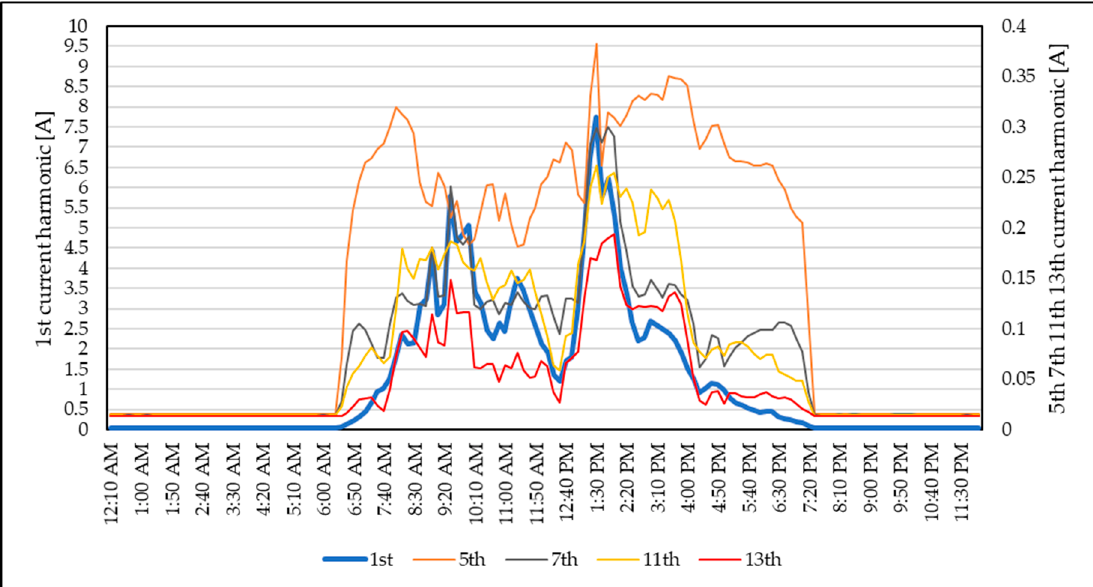
Figure 5. Effective current values of the 1st, 5th, 7th, 11th, and 13th current harmonics during a partially cloudy day (15 April 2018).